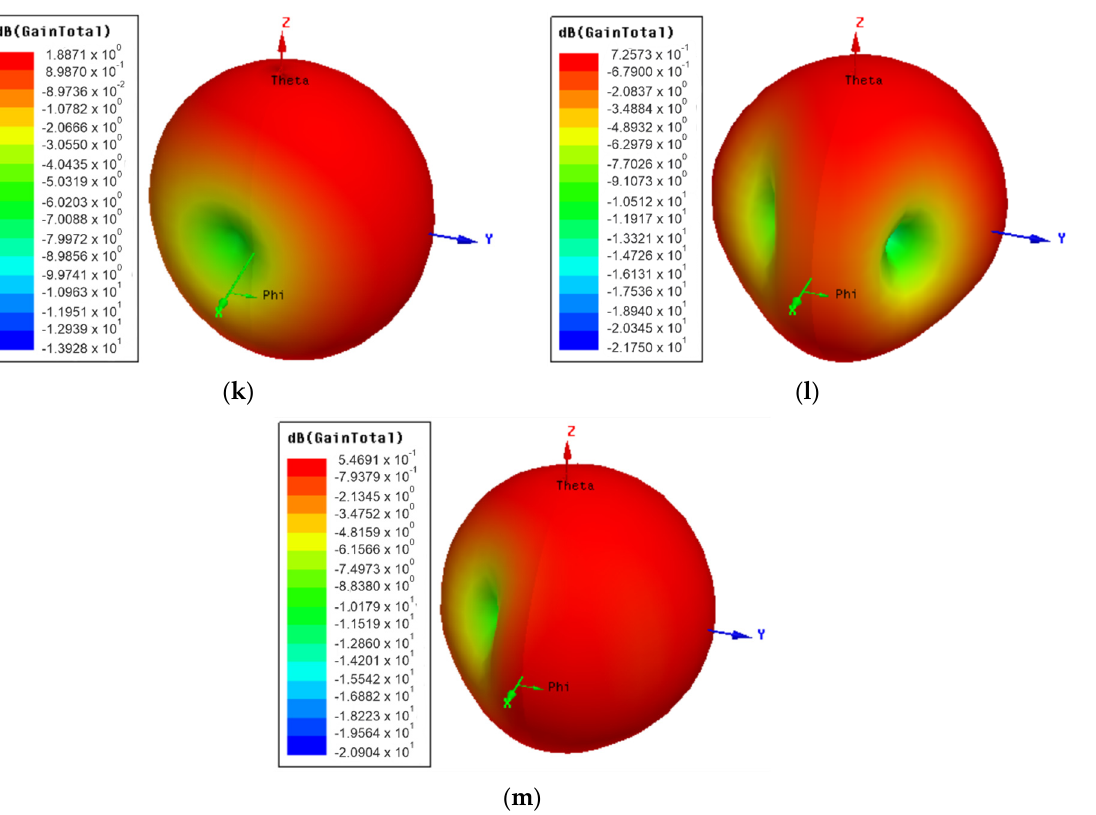
Figure 13. Proposed dual-band MIMO antenna simulated and measured parameters. ( a ) Measured S-parameters. Port 1 results: ( b ) Simulated and ( c ) measured 2-D radiation patterns at 3.5 GHz and 𝜙 = 0° (x-z plane) in red color, and 𝜙 = 90° (y-z plane) in black color. Port 2 results: ( d ) Simulated and ( e ) measured 2-D radiation patterns at 3.5 GHz and 𝜙 = 0° (x-z plane) in red color, and 𝜙 = 90° (y-z plane) in black color. Port 1 results: ( f ) Simulated and ( g ) measured 2-D radiation patterns at 5.45 GHz and 𝜙 = 0° (x-z plane) in red color, and 𝜙 = 90° (y-z plane) in black color. Port 2 results: ( h ) Simulated and ( i ) measured 2-D radiation patterns at 5.45 GHz and 𝜙 = 0° (x-z plane) in red color, and 𝜙 = 90° (y-z plane) in black color. Simulated 3-D radiation patterns results at 3.5 GHz: ( j ) Port 1 and ( k ) port 2. Simulated 3-D radiation patterns results at 5.45 GHz: ( l ) Port 1 and ( m ) port 2.